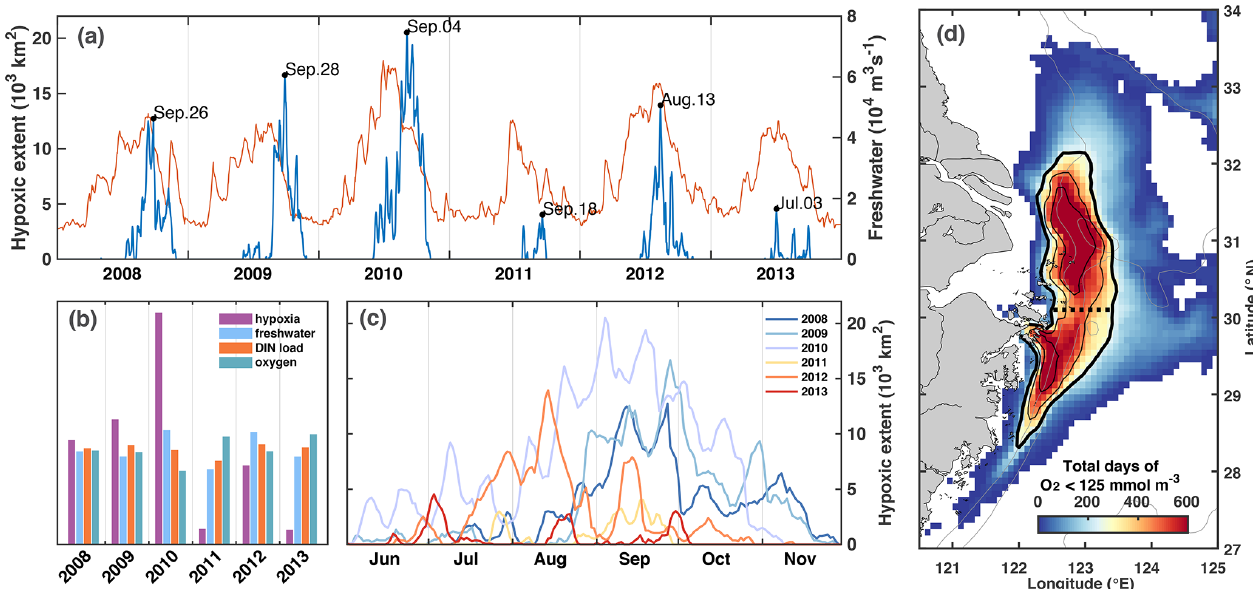
Figure 4. (a) Time series of freshwater discharge (thin red line) and simulated hypoxic extent (thick blue line) with peaks specified by date. (b) Annual comparison of normalized time-integrated hypoxic extent, freshwater discharge, DIN load, and summer-mean bottom oxygen concentration. (c) Evolution of simulated hypoxic extent by year. (d) Frequency map of number of days when bottom oxygen concentrations were below 125mmolm − 3 (4mgL − 1 ). The black isolines indicate 240, 360, and 480d (or 40, 60, and 80dyr − 1 ). The thick solid line indicates the region we refer to as the typical low-oxygen zone, and the dashed line shows the demarcation between its northern and southern